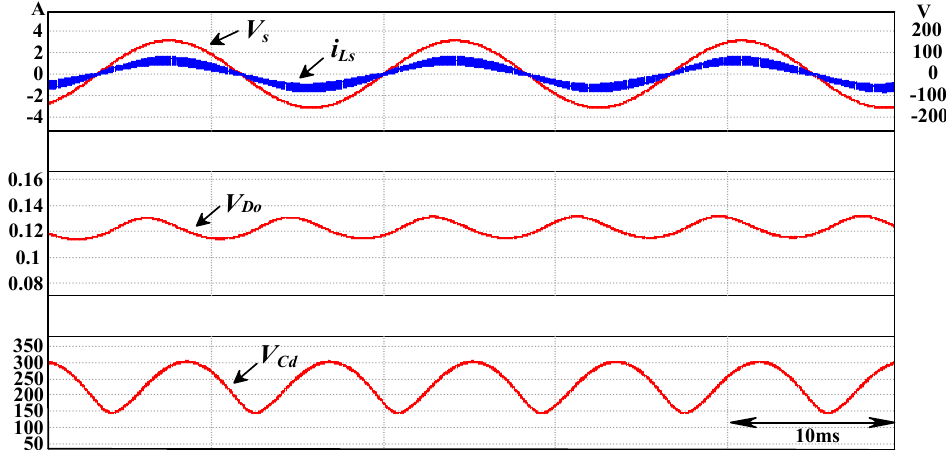
Figure 18. Simulation results for (top) the input voltage V s , current i s , and (bottom) corresponding intermediate capacitor voltage while the load is a dc motor.